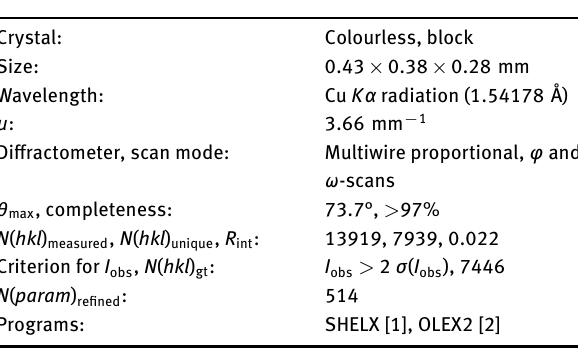
Table 1: Data collection and